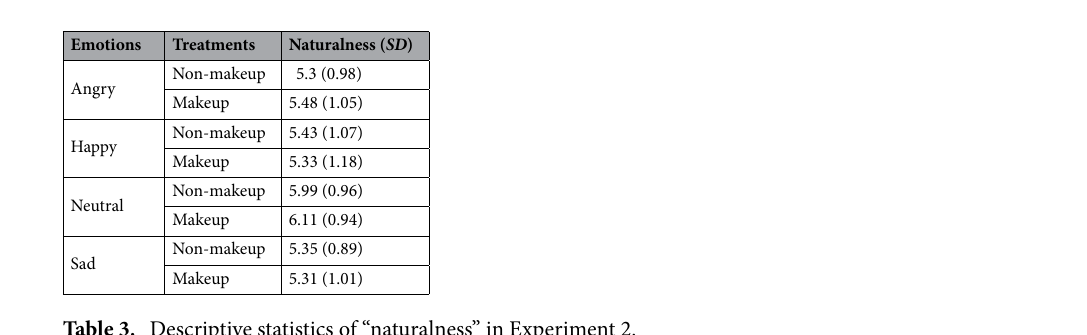
Table 3. Descriptive statistics of “naturalness” in Experiment